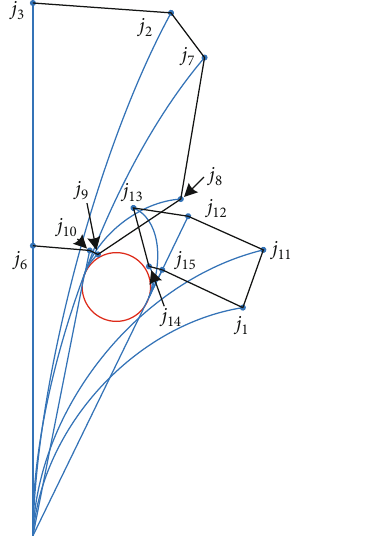
Figure 12: Landing footprints for Case 4.